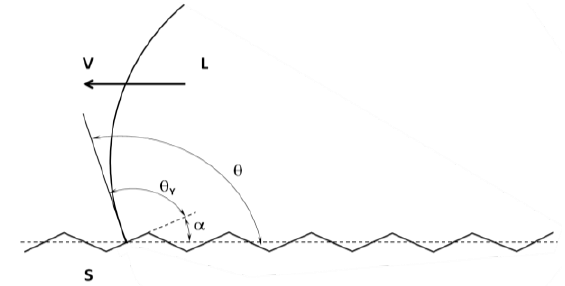
Fig. 2 - Pinning of the triple line during wetting on a rough surface. Pinning corresponds to a metastable state where the macroscopic contact angle θ satisfies the relation θ= θ